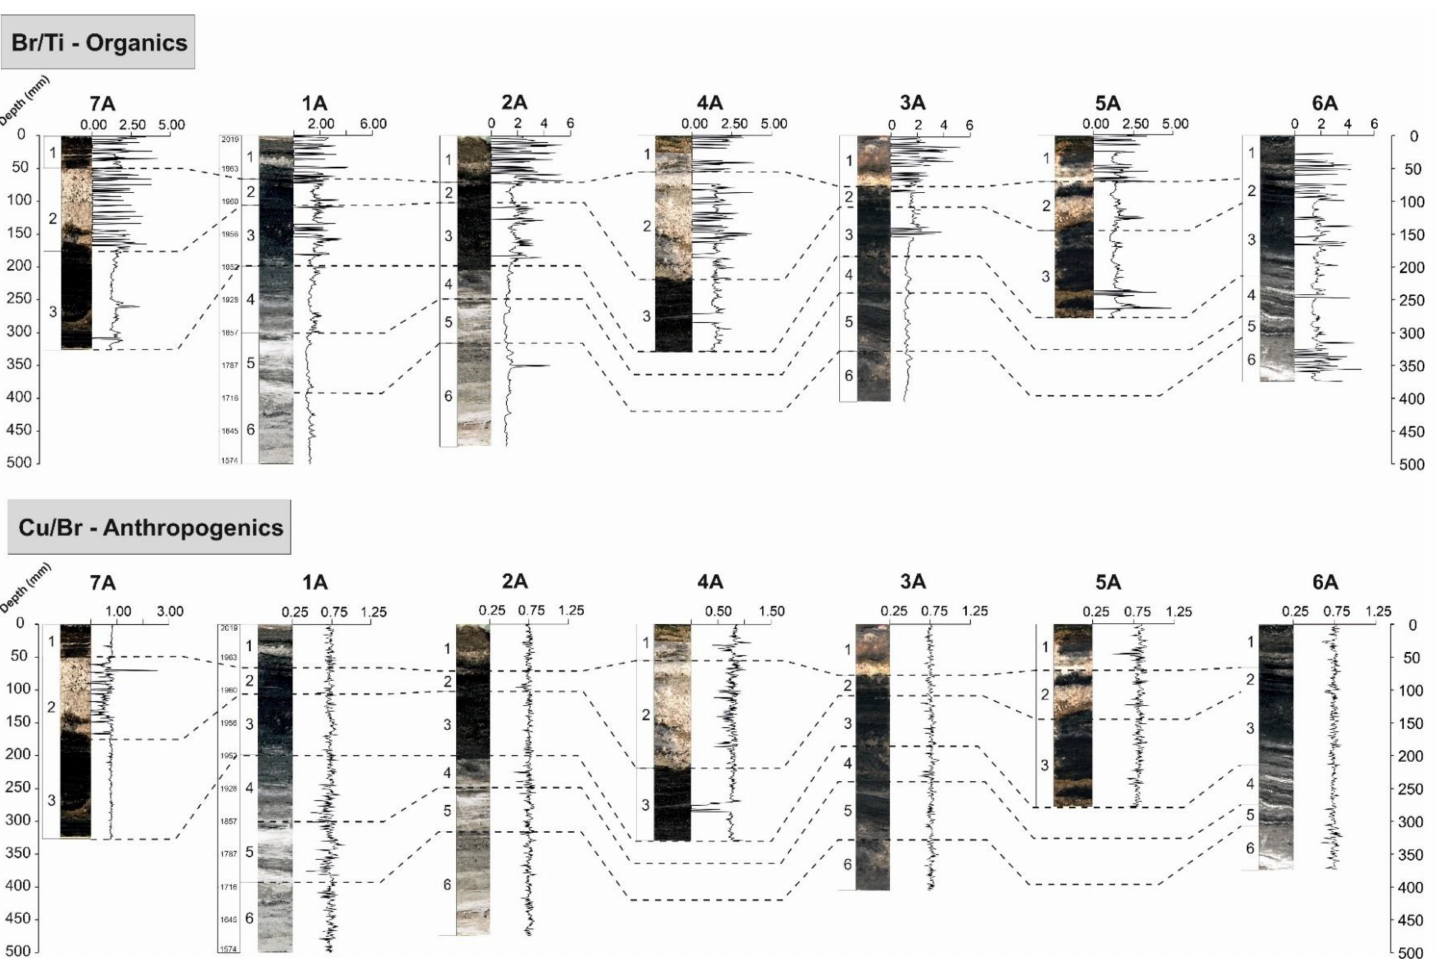
Figure 11. Figure illustrating spatio-temporal variations in geochemical proxies typically used for determination of the degree of organics/bioproductivity [80] and anthropogenic input [81]. Cu/Br is used here due to the strong association of organics with Cu and Ni (see discussion). Increasing values indicate increasing organic content and anthropogenic input,